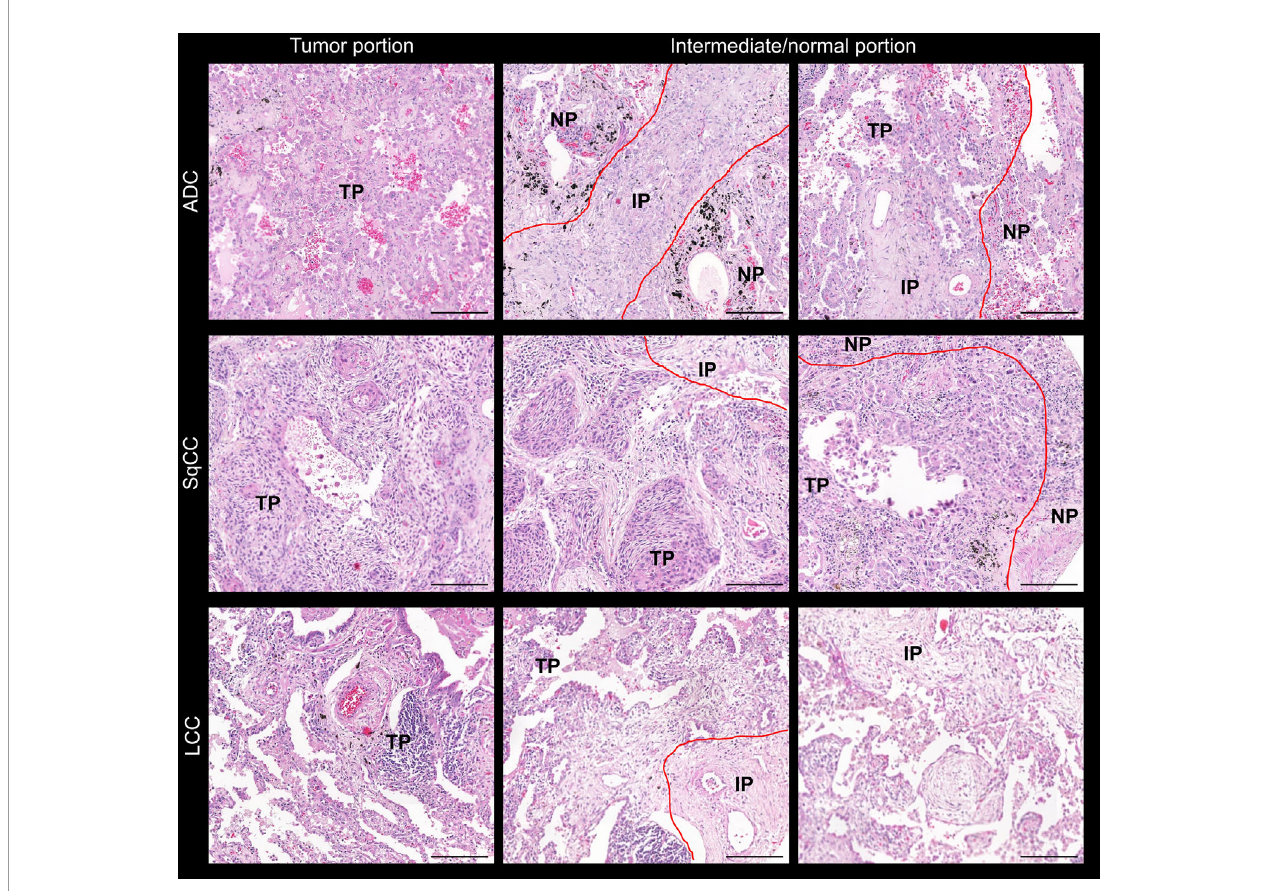
FIGURE 1 | Microphotographs of representative examples of the TMAs stained by H&E in lung ADC, SCC, and LCC specimens. Lung tissue was divided into three comparments: normal tissue, tumor tissue, and intermediate (red lines). ADC, adenocarcinoma; LCC, large cell carcinoma; SqCC, squamous cell carcinoma; TP, tumor portion; IP, intermediate portion; NP, normal portion. Scale bar: 1